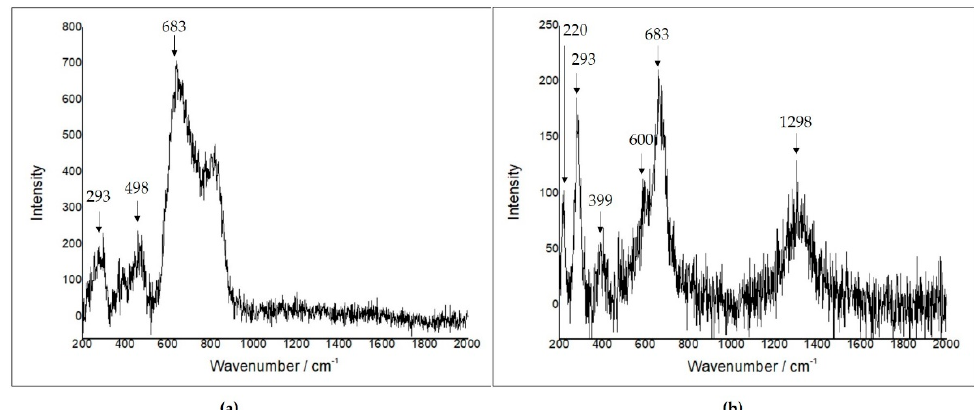
Figure 8. Raman spectra, measured at 5 mW laser power, of ilmenite inclusions showing different patterns as reported in the main text; ( a ) sample DL85 from Di Linh and ( b ) sample GL25 from Pleiku.